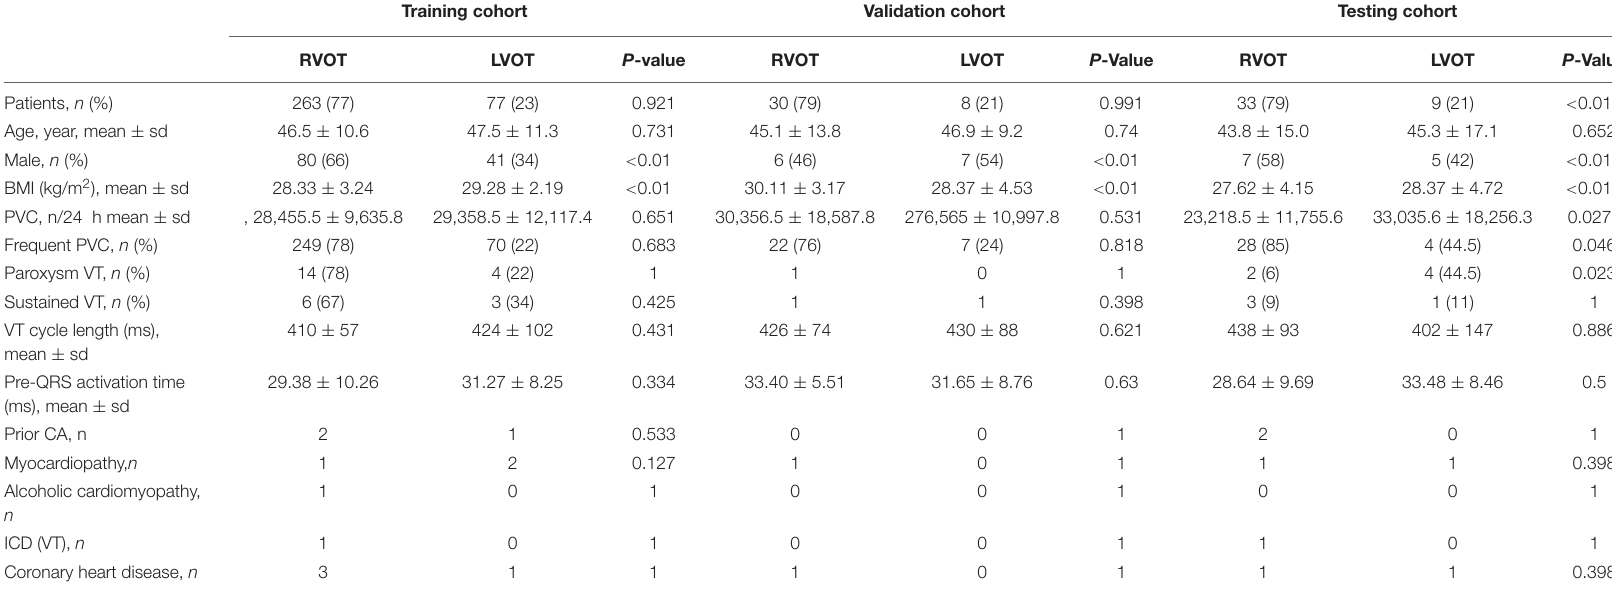
P-values present the probabilities of equal means or proportions of each tested variable. LVOT, left ventricular outflow tract; RVOT, right ventricular outflow tract; BMI, body mass index; LVEF, left ventricular ejection fraction; PVC, premature ventricular complex; VT, ventricular tachycardia; CA, catheter